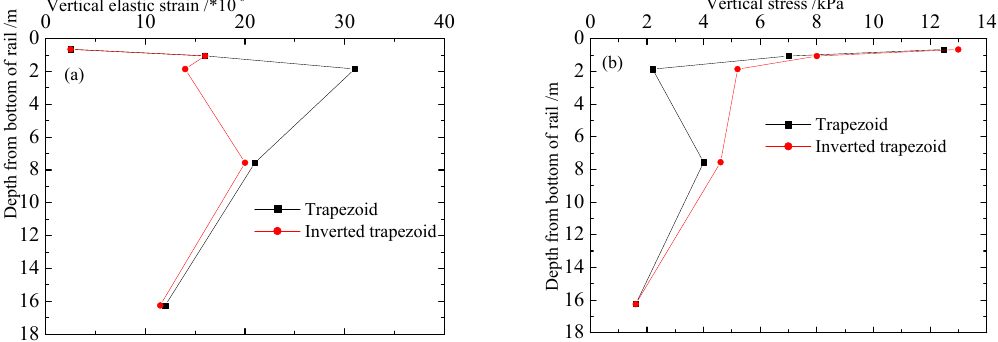
Figure 13. Variation of dynamic response with depth: ( a ) vertical elastic strain; ( b ) vertical dynamic stress.